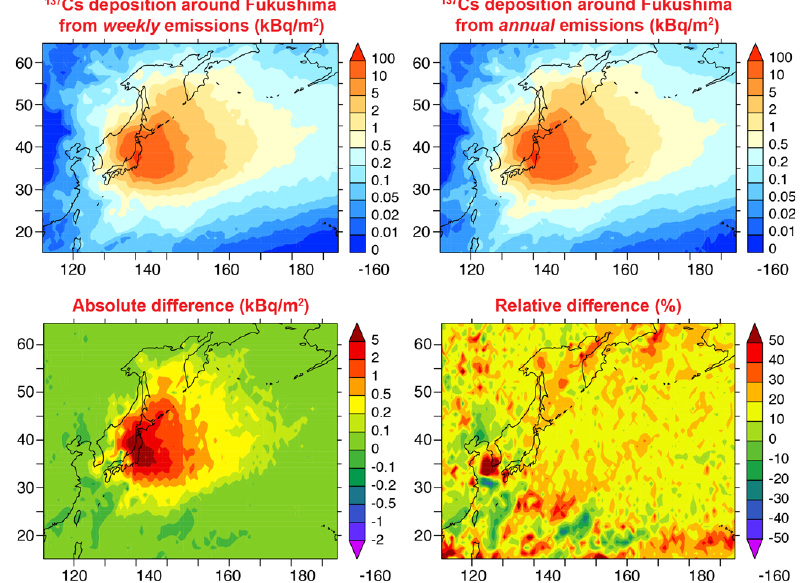
Fig. 9. Yearly-integrated fallout of 137 Cs (year 2005), comparing annually continuous to weekly emissions (both the same total source strength of Chernobyl), released from the location of